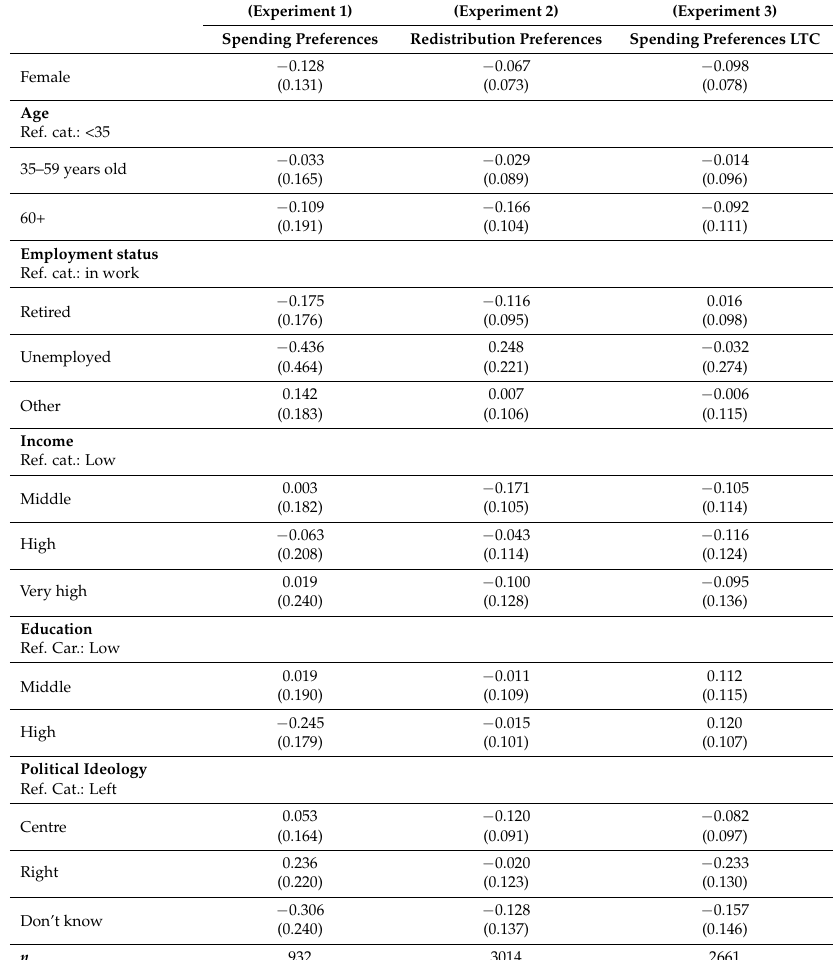
Table A1. Balance check between treatment and control group—Logistic